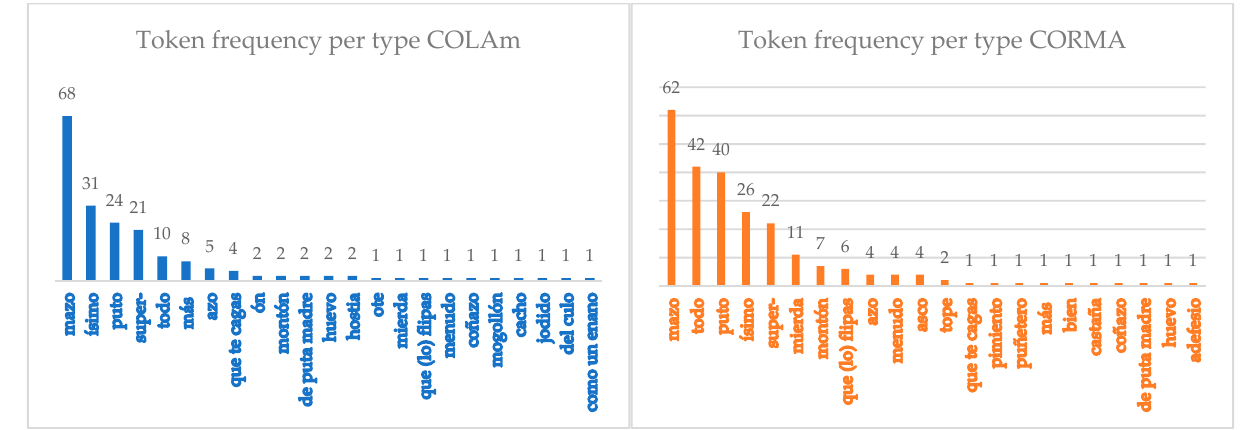
Figure 1. Comparison of the paradigm of morphological and lexical intensifier types in COLAm and CORMA.